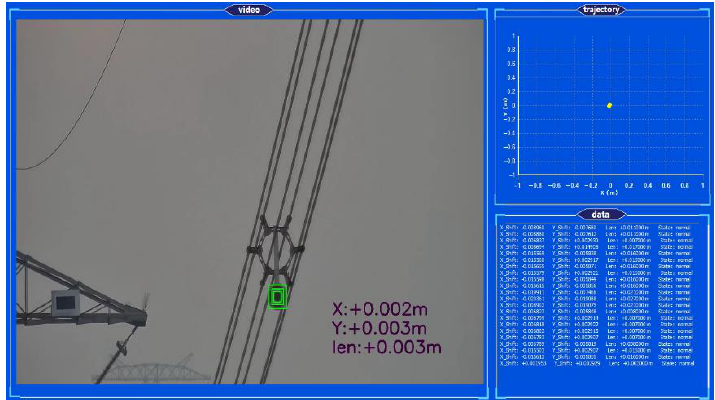
Figure 8. The recognition performance on foggy days.